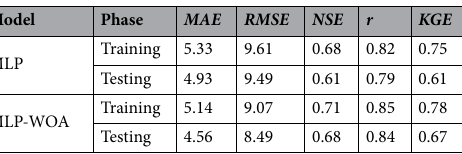
Table 11. The results of the applied metrics on the calibration and validation phases of the MLP and coupled MLP-WOA models.